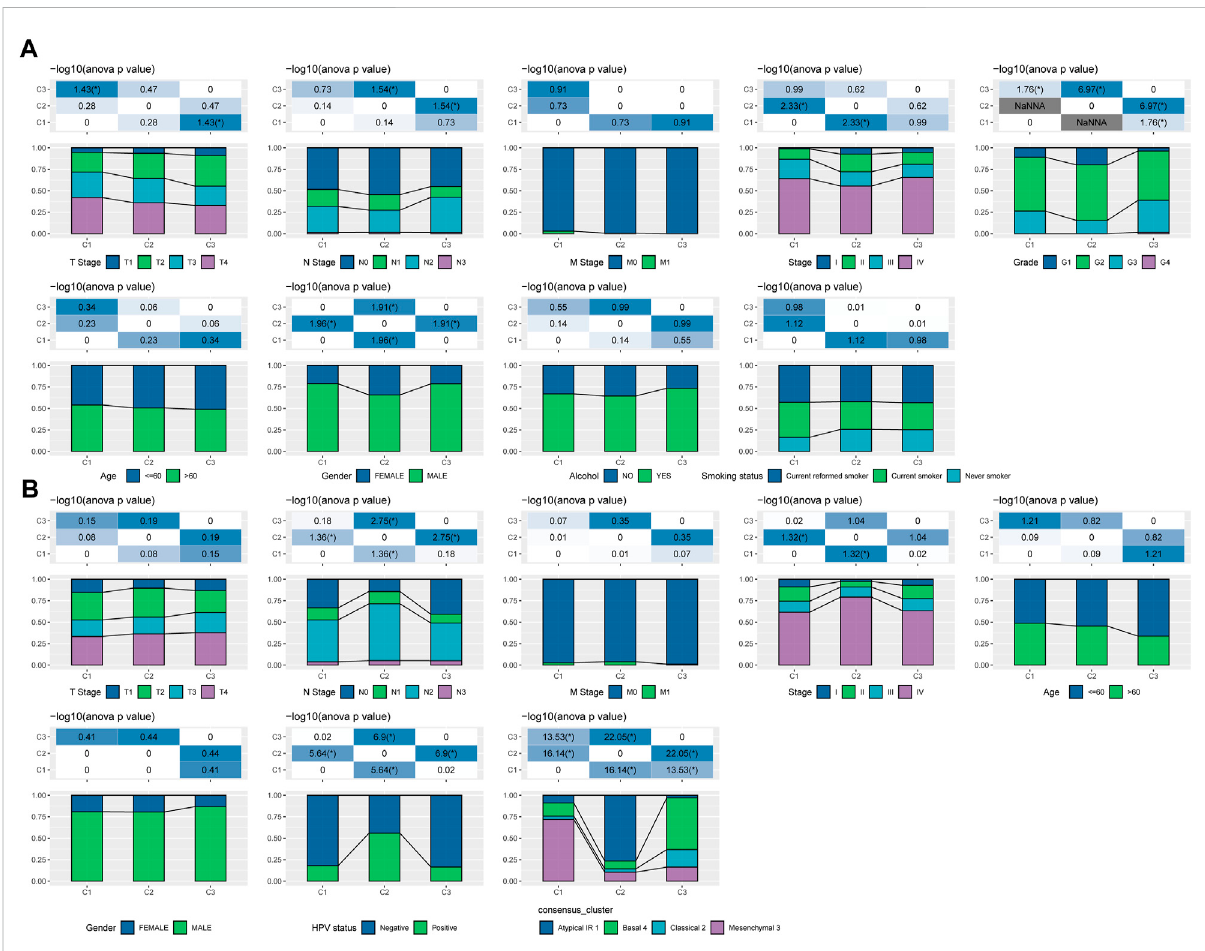
FIGURE 2 Clinicopathological features between molecular subtypes. (A) Clinicopathological characteristics of molecular subtypes of the TCGA-HNSC cohort; (B) Clinicopathological characteristics of molecular subtypes of the GSE65858 cohort; the lower half is the proportion, and the upper half is the distribution difference between the pairwise statistically signi fi cant-log10 ( p